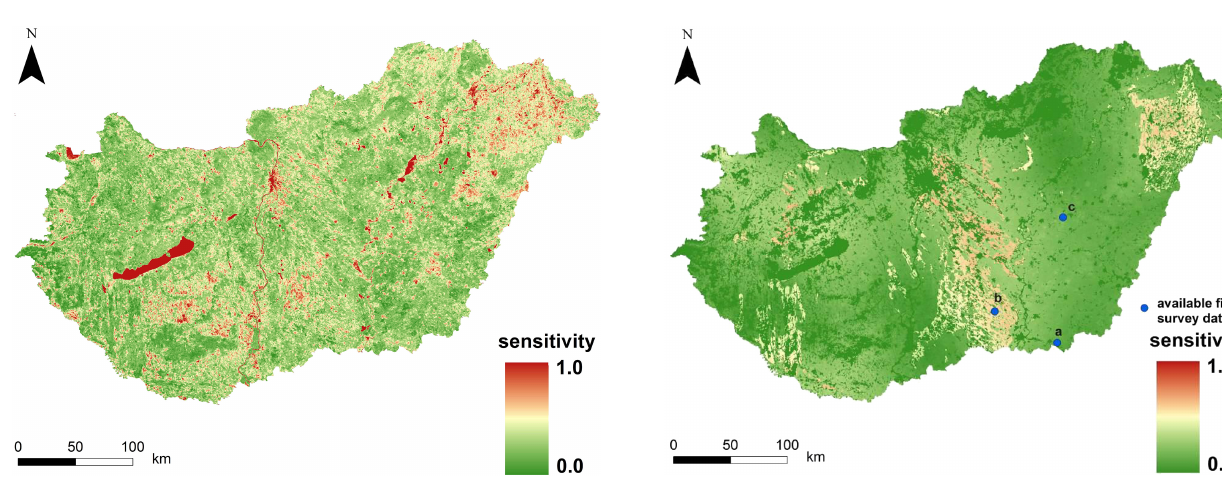
Figure 13. Wind erosion sensitivity at a regional level with a land cover mask to exclude forests and urbanised areas and the study sites for validation where field survey data are available ( a Apát- falva, b Kömpöc, c Tisza